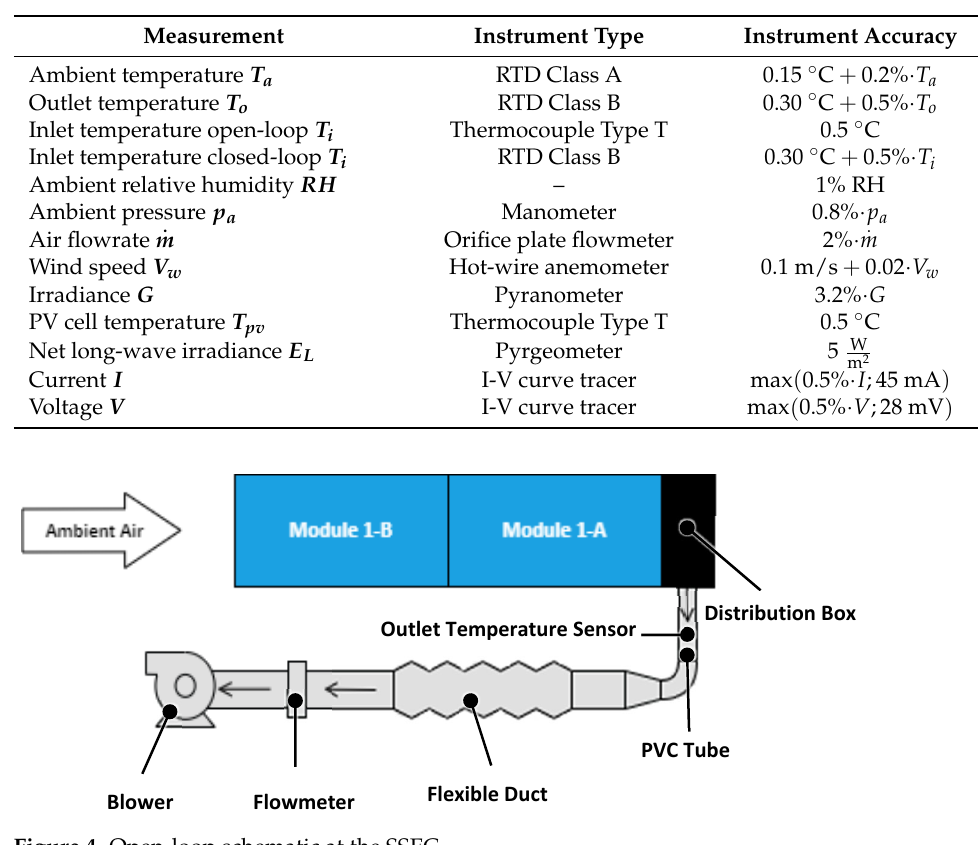
Figure 4. Open-loop schematic at the SSEC. Figure 4. Open ‐ loop schematic at the SSEC. Table 5. Steady ‐ state criteria for indoor testing.